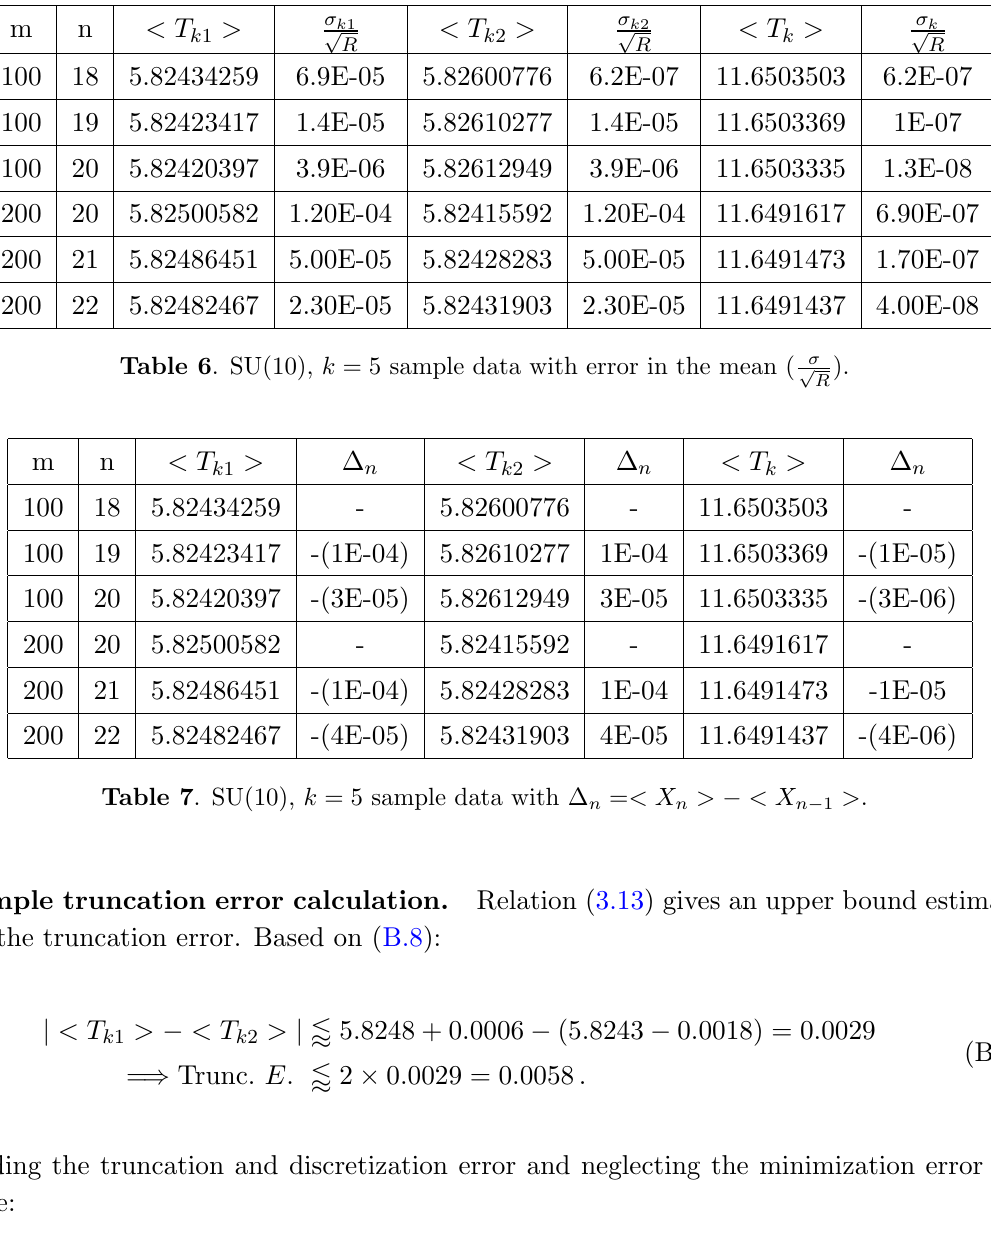
Table 6 . SU(10), k = 5 sample data with error in the mean ( (cid:27) p